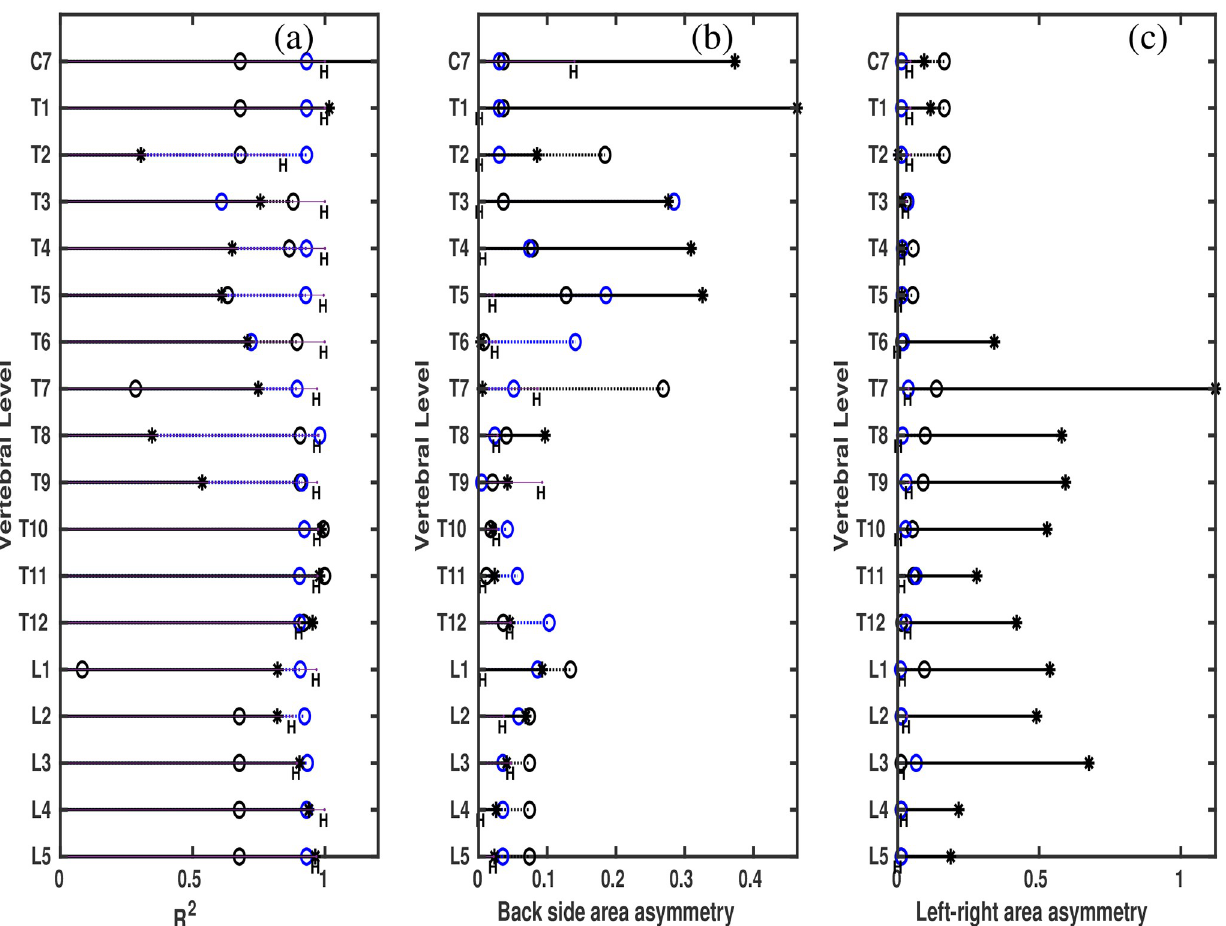
Fig 5. Asymmetry parameters along vertical body axis. Asymmetry parameters at different vertebral levels for the cases analyzed here. The letter ‘ H ’ represents the value for the healthy participant, ‘ o ’ for the case of P1 from her first scan, o for the case of P1 at her second scan, ‘ � ’ for the case of P2. (a) Shows R 2 values, (b) back side area asymmetry values, (c) left-right area asymmetry values.